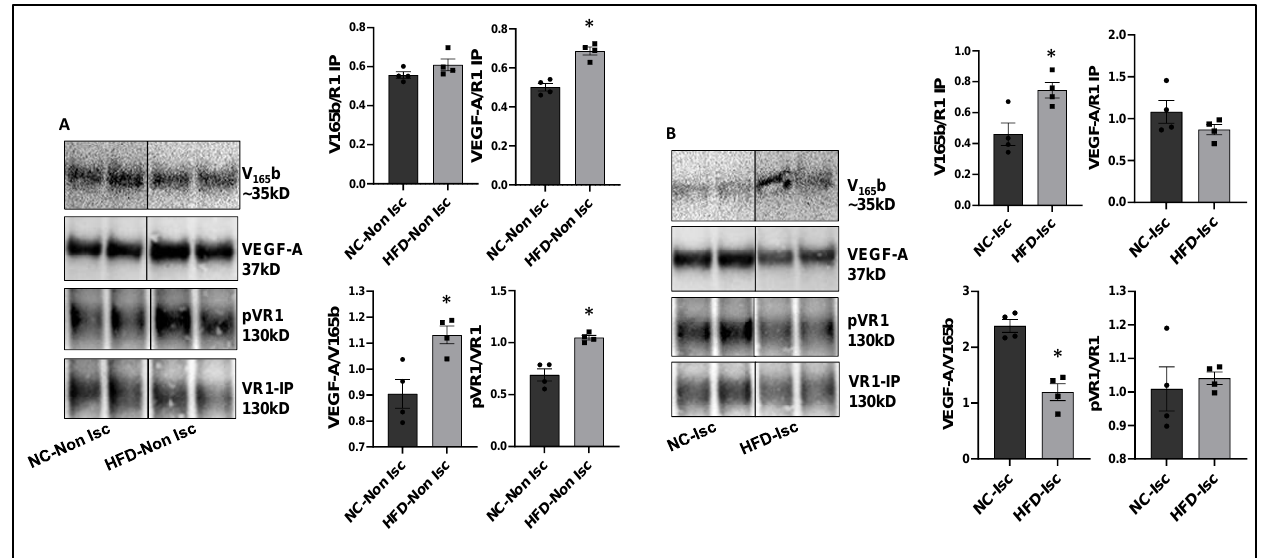
Figure 4. Increased binding of VEGF 165 b to VEGFR1 in HFD-ischemic muscle blocks VEGFR1 activation: ( A ) Immunoblot analysis of V 165 b, VEGF-A, and pVR1 in VEGFR1 pull-down fractions (VR1-IP (immunoprecipitated)) in normal chow- (NC) and high-fat diet (HFD)-fed C57BL/6 non-ischemic muscle. n = 4. Unpaired t -test. ( B ) Immunoblot analysis of V 165 b, VEGF-A, and pVR1 in VEGFR1 pull-down fractions (VR1-IP) in normal chow and high-fat diet-fed C57BL/6 ischemic muscle at day 3 post-HLI. n = 4. Unpaired t -test. * p < 0.05 considered significant. Data Mean ± SEM. After confirming that ischemia induces VEGF 165 b binding to VEGFR1 in HFD skeletal muscle, we determined the functional role of VEGF 165 b-Ab in regulating perfusion recovery in HFD-ischemic muscle. VEGF 165 b-Ab or isotype-matched IgG (200 µ g/100 µ L PBS/mouse) was injected intramuscularly into HFD mouse gastrocnemius (two non- overlapping sites) and tibialis anterior (one site) immediately after HLI (d0) and days 3, 7, 14, and 21 post-HLI. VEGFR1 pull-down at day 3 post HLI with IgG or VEGF 165 b-Ab- treated samples showed a significant increase in total VEGF-A bound to VEGFR1 indicating that VEGF 165 b binding to VEGFR1 was reduced by VEGF 165 b-Ab treatment (Figure 5A). Laser Doppler showed that VEGF 165 b-Ab significantly improved limb perfusion (day 14: IgG-40.1 ± 2.4 vs. V 165 b-Ab-55.35 ± 4.7; day 21: IgG-35.3 ± 9.0 vs. V 165 b-Ab-65.22 ± 5.4; day 28: IgG-52.1 ± 8 vs. V 165 b-Ab-76.7 ± 3.2) in HFD-ischemic muscle vs. IgG (Figure